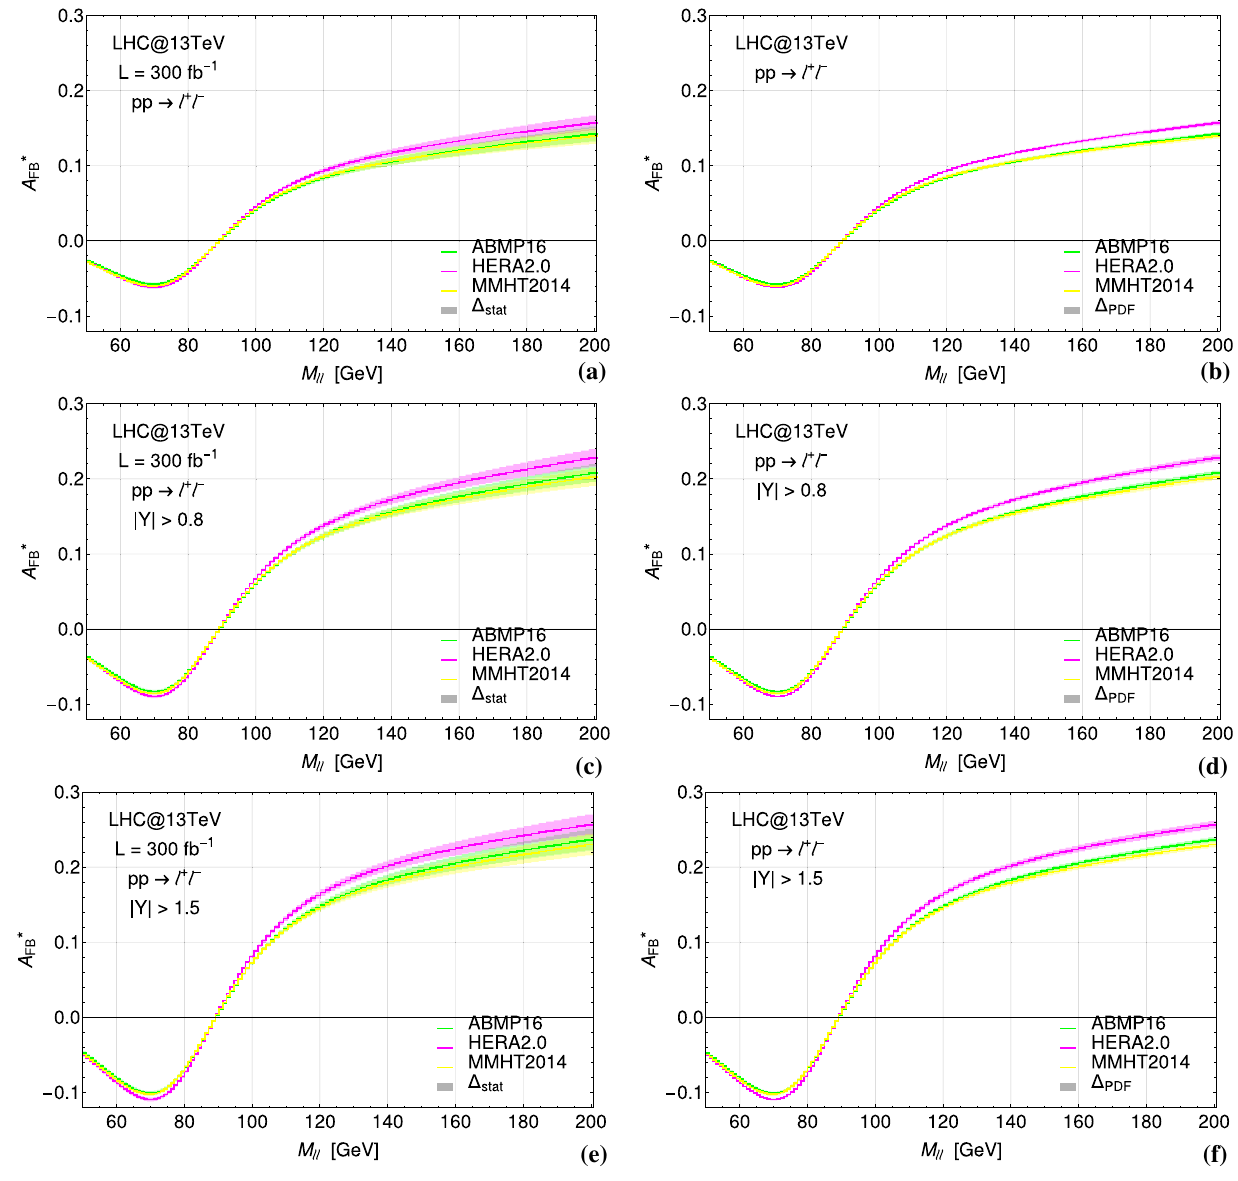
Fig. 2 A ∗ with its statistical (left column) and PDF (right column) error bands obtained with the ABMP16, HERA2.0 and MMHT2014 PDF sets FB with a rapidity cut of | y | > 0 (first row), | y | > 0 . 8 (second row) and | y | > 1 . 5 (third